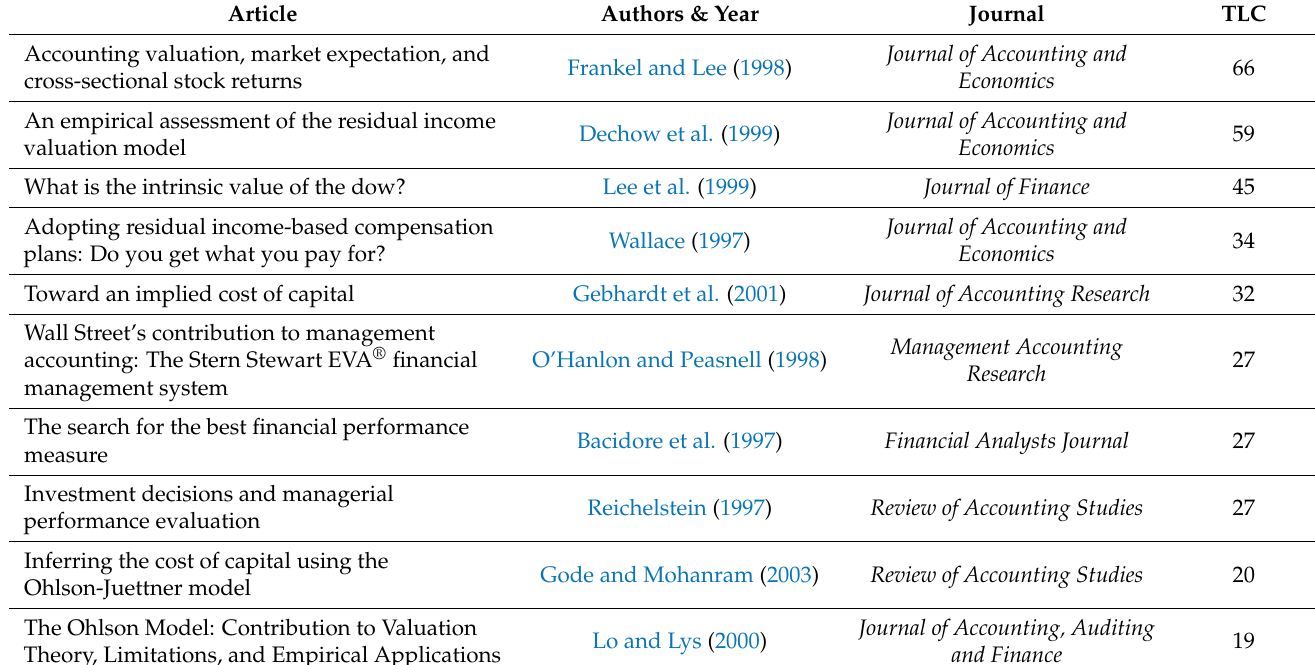
Table 4. Leading Articles in EVA Research Domain based on Total Local